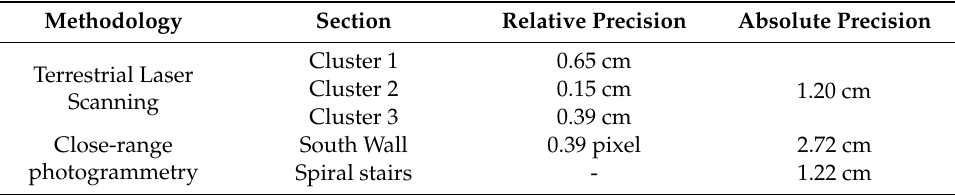
Table 4. Precision Obtained in the Orientation of Point Clouds.